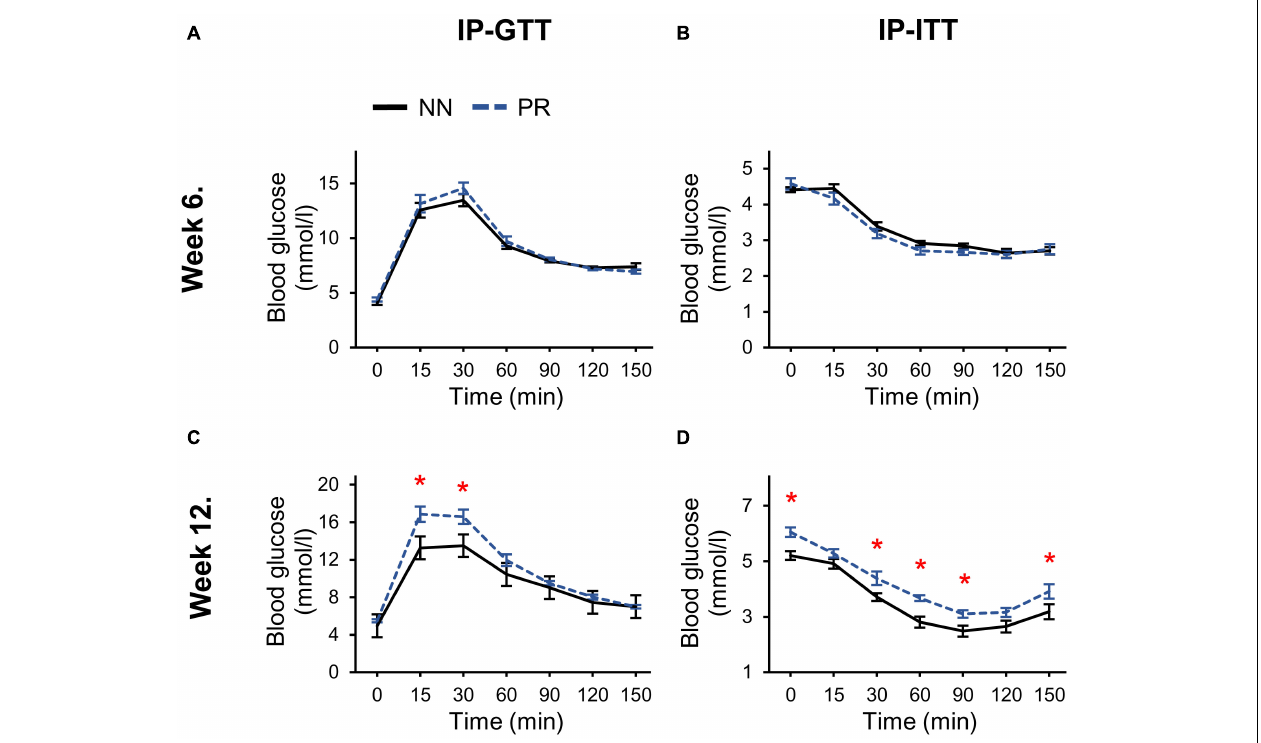
FIGURE 2 | Glucose and insulin tolerances of NN and PR rats. (A) Intraperitoneal glucose (IP-GTT) and (B) intraperitoneal insulin tolerance tests (IP-ITT) performed at postnatal week 6 show similar responses to glucose and insulin in both groups. (C) IP-GTT performed at postnatal week 12 shows decreased glucose tolerance of PR rats. Two-way RM ANOVA, effect of phenotype: F ( 1 , 78 ) = 6.494, p = 0.023, effect of time: F ( 6 , 78 ) = 87.342, p < 0.001, effect of phenotype × time: F ( 6 , 78 ) = 2.972, p = 0.011. (D) IP-ITT shows decreased insulin sensitivity of PR rats compared to NN controls. Two-way RM ANOVA, effect of phenotype: F ( 1 , 81 ) = 18.714, p < 0.001, effect of time: F ( 6 , 81 ) = 93.725, p < 0.001. Tukey multiple comparison tests, NN vs. PR within one time point, * p < 0.05. Means ± SEM, n = 8 for all